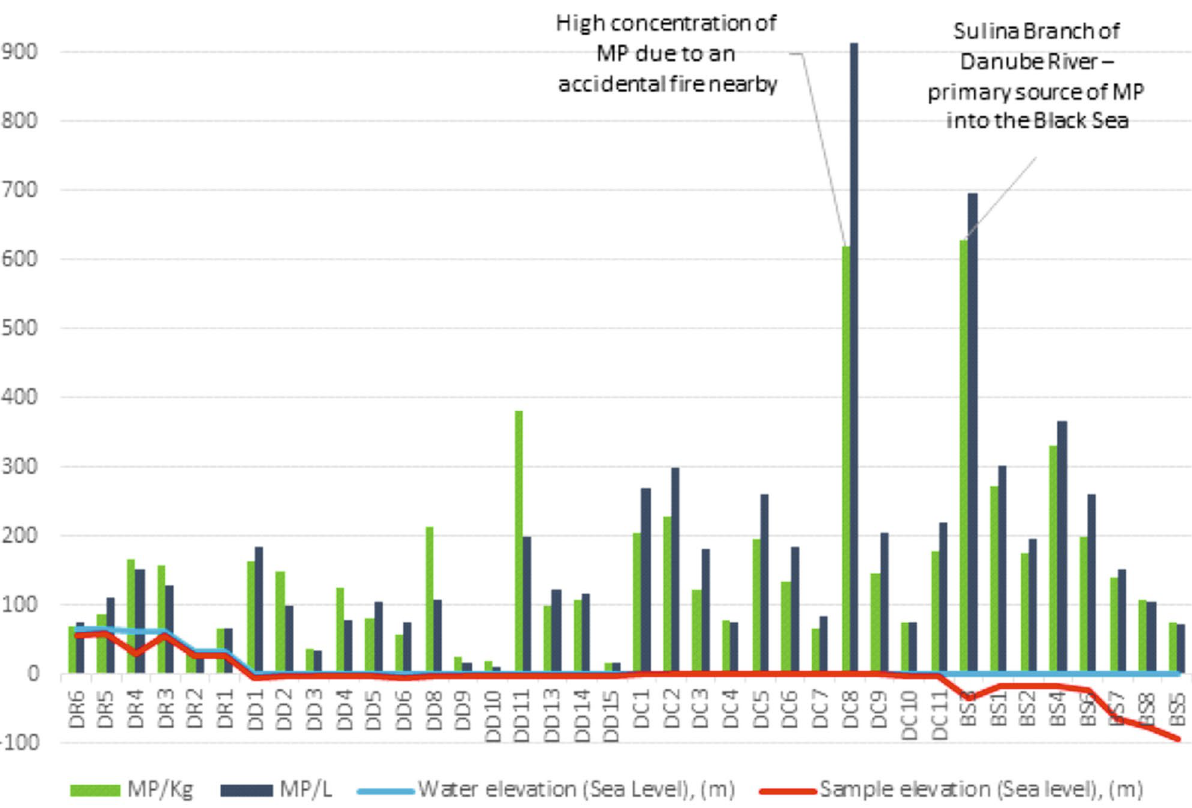
Figure 3. Microplastic particle abundance in the collected samples from the Danube River (left) to the Black Sea (right), showing the concentration in particles per 1 kg (green) and particles per 0.5 L (purple) of sediment. Also indicated are water level (blue) and sample elevation